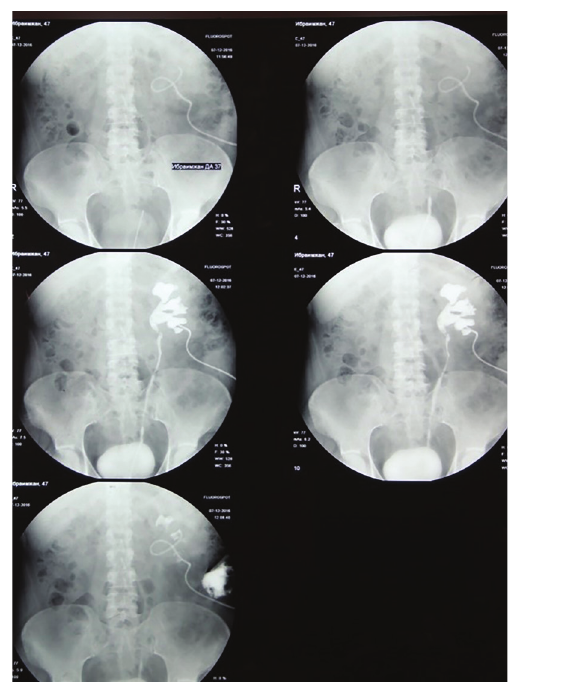
Figure 9 - Antegrade left pyelography